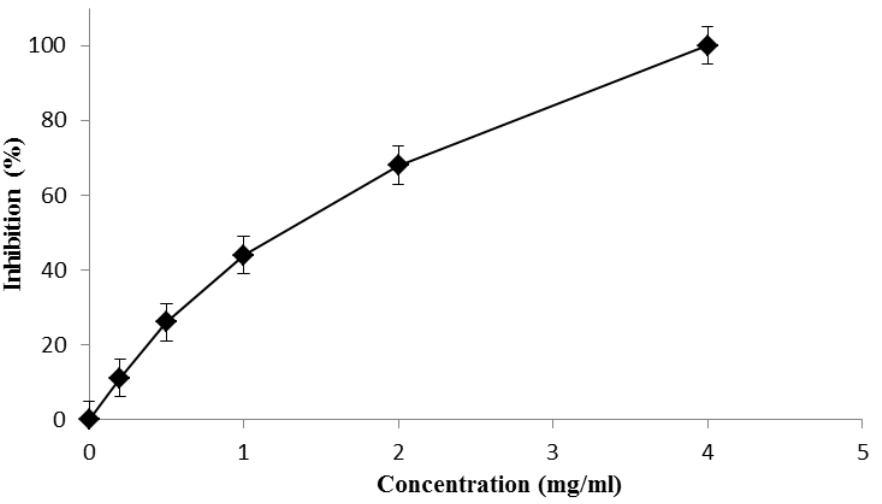
Figure 1. DPPH radical scavenging effect on different concentrations of fig syrup after 30 min